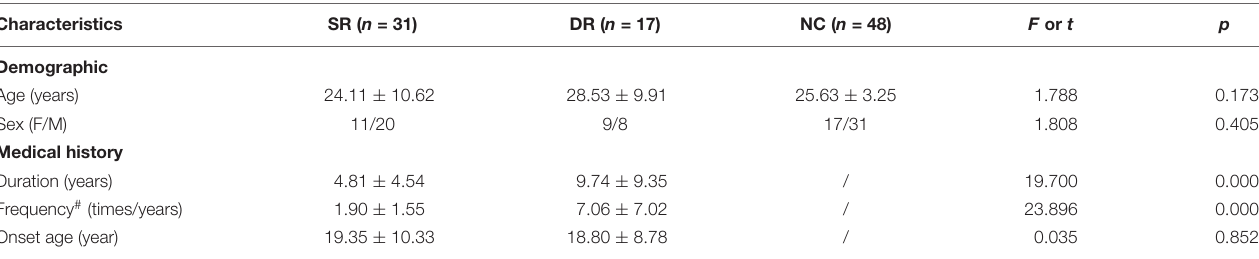
TABLE 1 | Demographic and clinical characteristics of the